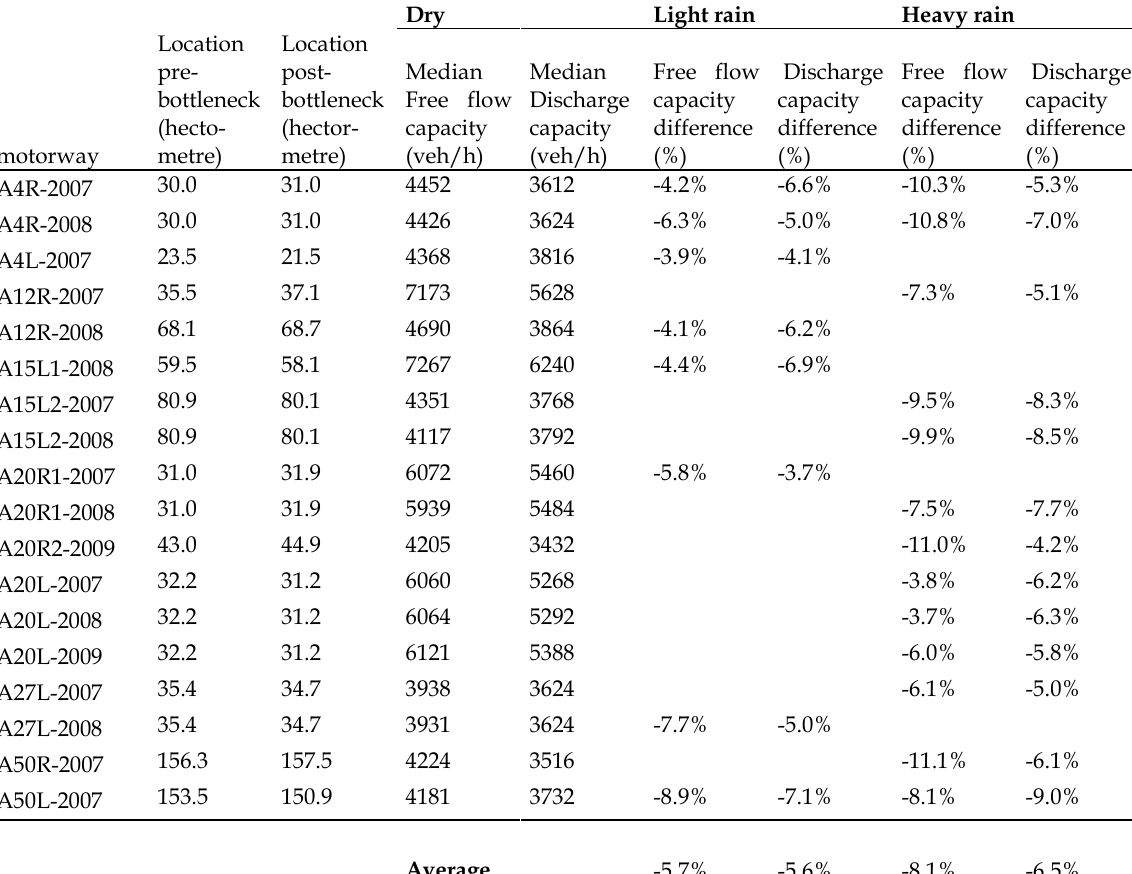
Table 2. Comparison of the median capacity values in the different scenarios Dry Light rain Heavy